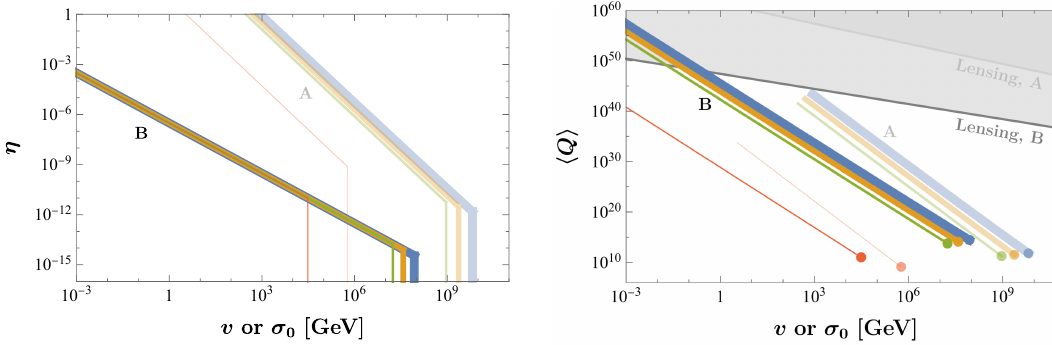
Figure 6 . Left panel: The values of η and v or σ 0 that give the right abundance of Q-balls for them to make up all dark matter from an FOPT without solitosynthesis. Right panel: The corresponding average charges of the Q-balls produced making up all dark matter. The points at the bottom right of each curve represent the values consistent with η = 0 and the statistical fluctuations in the symmetric component of the S particles dominate, i.e., where the curves become vertical in the left panel. In both panels, Models A and B are plotted in lighter and darker colors, respectively, and the constraint η < 1 has been imposed. Here, T n = v or σ 0 , v sh = 1 , (cid:15) n = 0 . 01 , p in = 1 , and the curves correspond to — from thickest to thinnest and right to left — the values a = 100 (blue), 10 − 1 (yellow), 10 − 4 (green), and 10 − 30 (red). Microlensing constraints on m Q > 10 23 g are shown in shaded gray